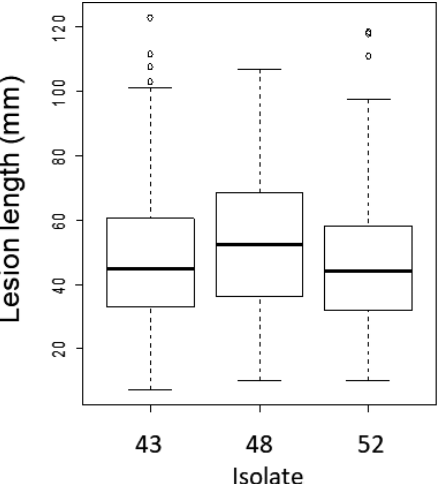
Figure 5. Boxplots of average lesion lengths recorded after inoculations of grapevines with three Phaeomoniella chla- mydospora isolates. The median is represented by the solid line.